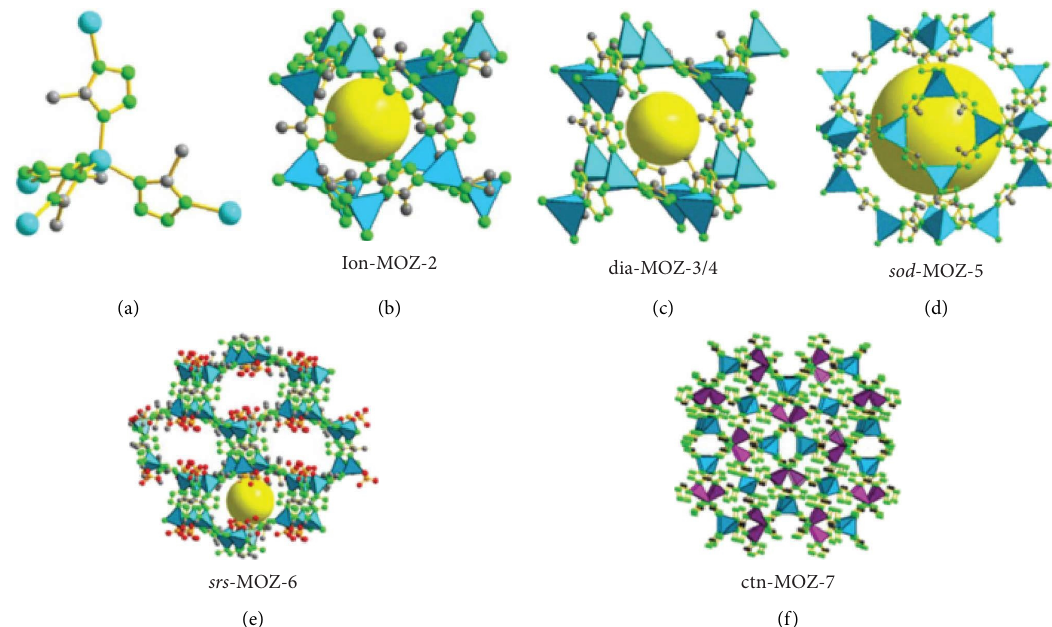
Figure 6: Tetrahedral union [Zn(5-mtz) 4 ] (a) used for synthesizing fve structural zeolite@MOF isomers, including ion-type MOZ-2 (b); dia-type MOZ-3 (c); SOD-type MOZ-5 (d); srs-type MOZ-6 (e); and ctn-type MOZ-7 (f) are adopted from